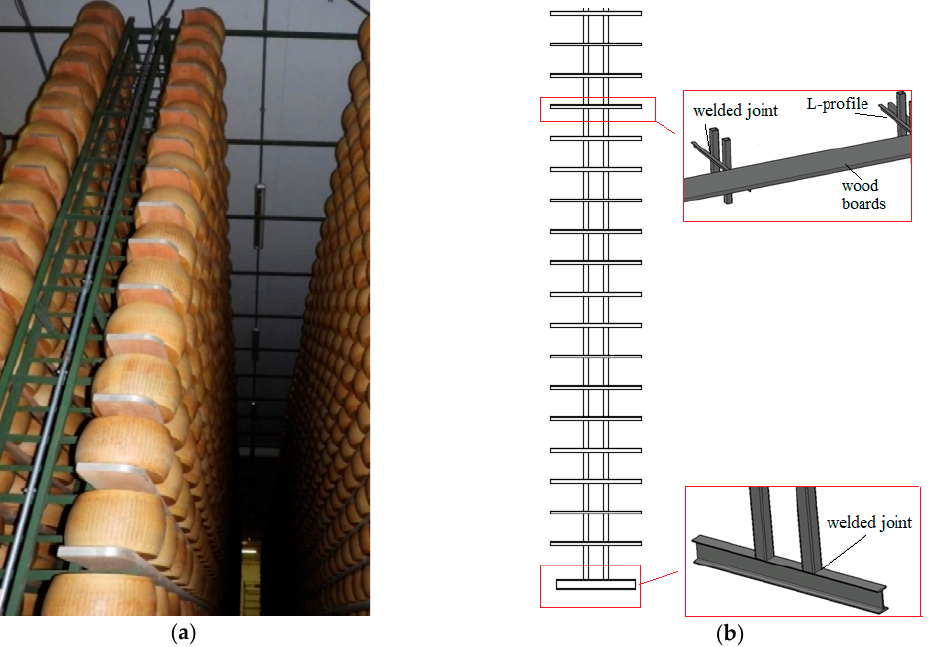
Figure 2. Details of the old type grana cheese racks: ( a ) picture and ( b ) sketch.